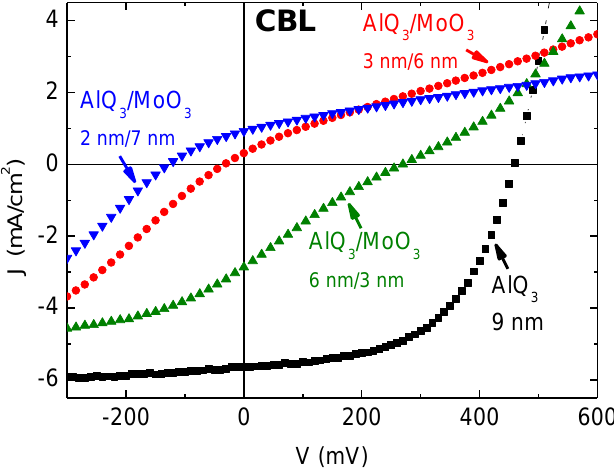
Figure 1. J-V characteristics of ITO (100 nm)/MoO ( x nm)/MoO ( y nm)/Al organic photovoltaic cells (OPVCs) with different thicknesses for 3 the constituents of the Alq /MoO 3 3